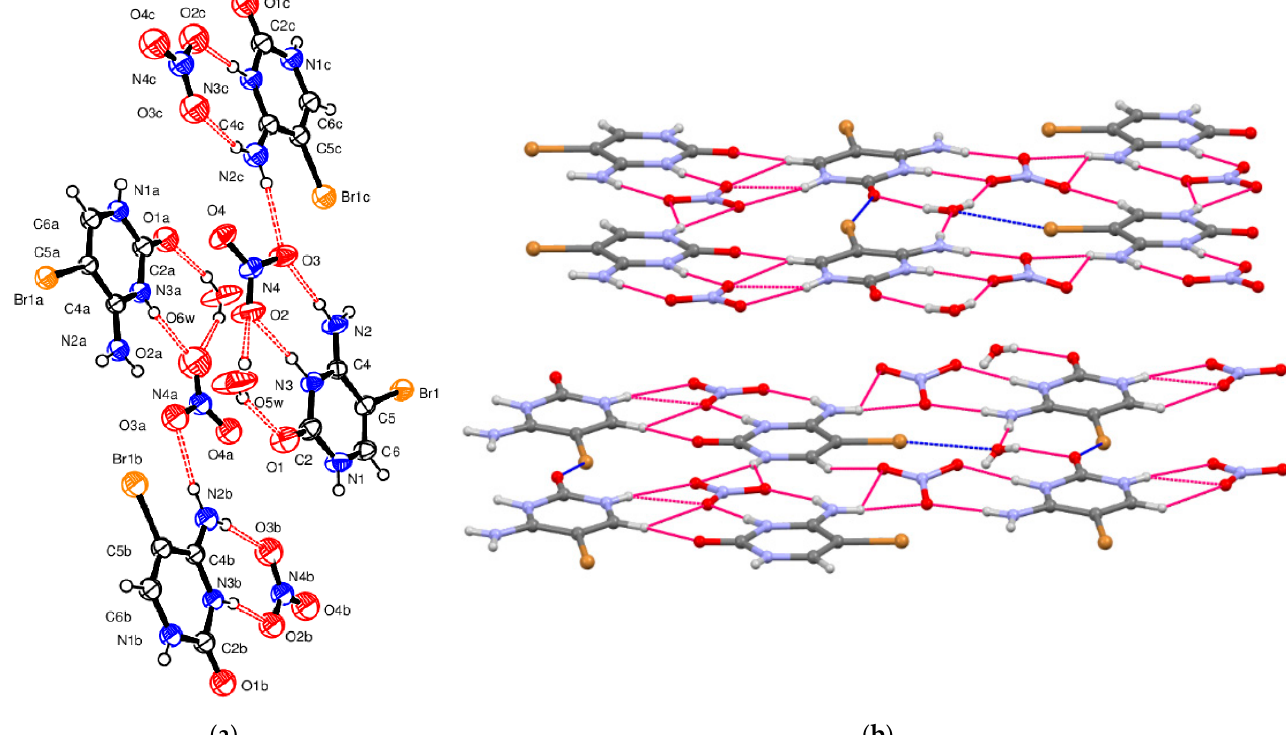
Figure 3. ( a ) The asymmetric unit of compound ( III ), showing the adopted atom-numbering scheme. Displacement ellipsoids are at the 50% probability level. H atoms are shown as small spheres of arbitrary radii. Hydrogen bonding is shown as red dashed lines. ( b ) Part of the crystal structure of ( III ). All atoms are shown as small spheres of arbitrary radii. Hydrogen bonding is shown as red dashed lines. Halogen bonding is shown as blue dashed lines.